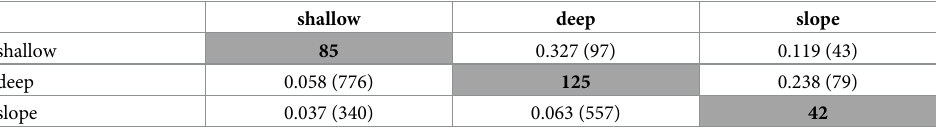
Table 3. Pair-wise F ST values between the “shallow”, “deep” and “slope” ecotypes of S . mentella identified by DAPC analyses. shallow deep slope shallow 85 0.327 (97) 0.119 (43) deep 0.058 (776) 125 0.238 (79) slope 0.037 (340) 0.063 (557) 42 P < 0.00001 for all comparisons. F ST estimates using 1,943 neutral (below diagonal) and 97 outlier (above diagonal) SNPs are shown. Collection sizes are presented along the